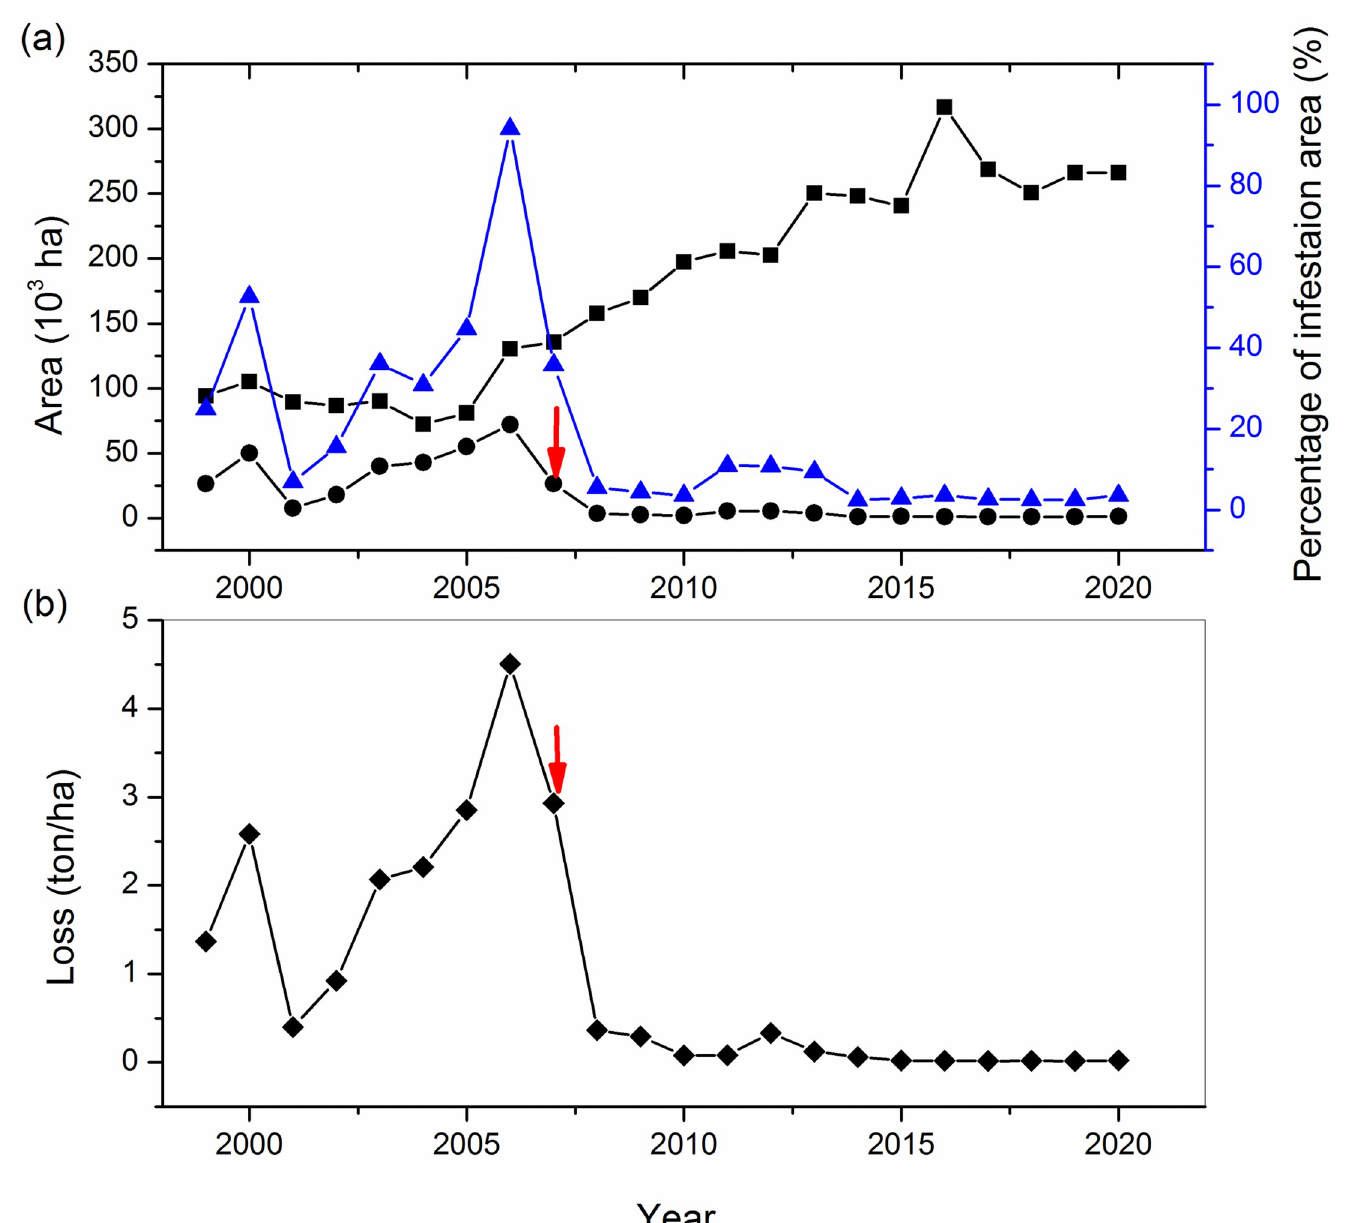
Fig 1. Area planted to sunflower and area of infestation of sunflower by H . nebulellum in Bayannur from 1999 to 2020. (a) Area of sunflower planting and infestation, and (b) sunflower production loss. (a) The symbol square, circle, and up triangle indicates planting area, infestation area, and percentage of infestation area, respectively. Red arrows indicate first partial regional implementation of delayed planting dates in 2007. Data was from Bayannur Station of Plant Protection.